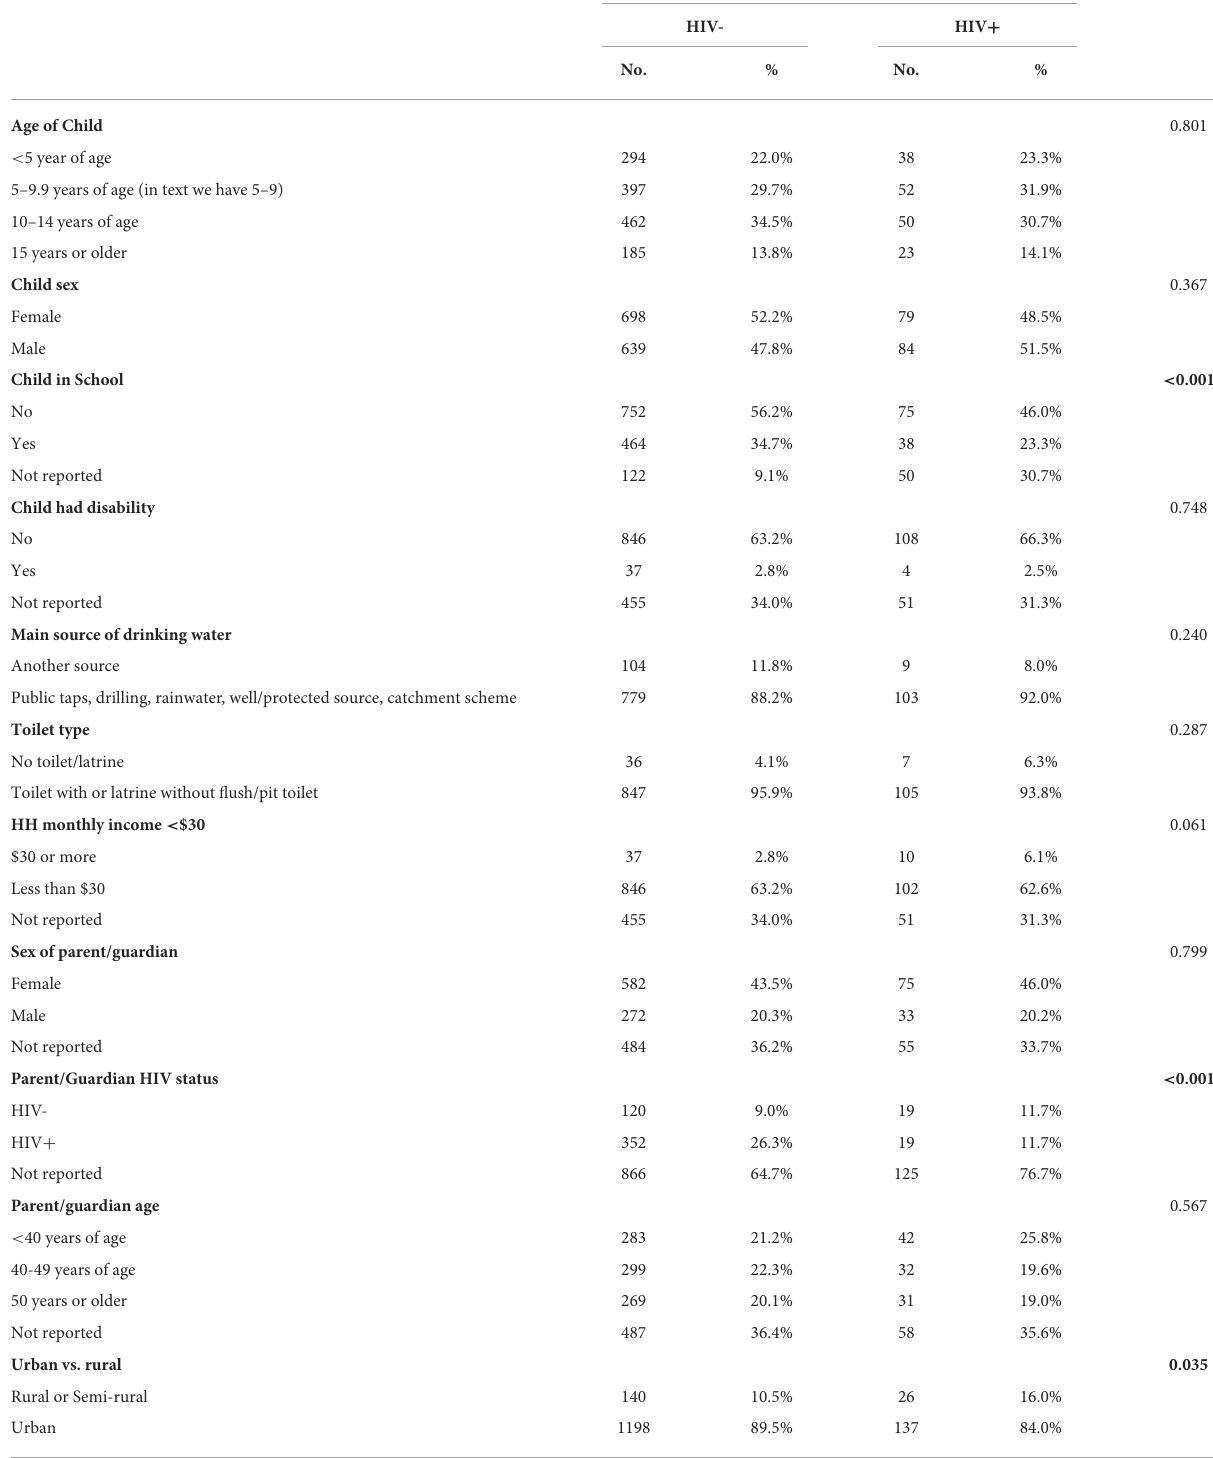
TABLE 2 Bivariate Analysis of HIV Status in OVC (Chi-Square), Jan. 2017 to Apr. 2020. Child, parent/guardian and facility characteristics HIV Status P *